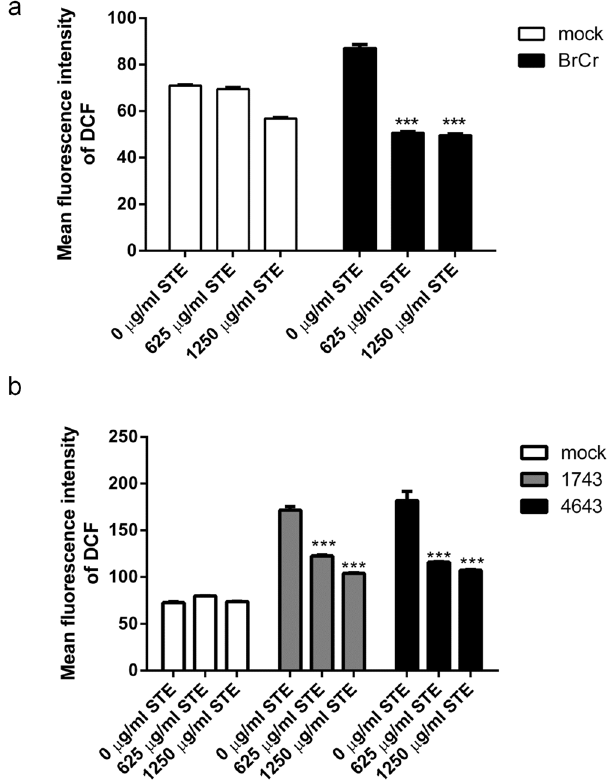
Figure 6. STE suppresses EV71-induced ROS generation. RD cells were mock- or infected with BrCr, 1743, and 4643 at m. o. i. of 0.05 for 1 hr, and subsequently treated with indicated concentrations of STE for 24 h. Cells were loaded with H 2 DCFDA at 37 °C for 30 min, and analyzed cytometrically. Data are means ± SD of six separate experiments. *** P < 0.0001, vs. infected cells without